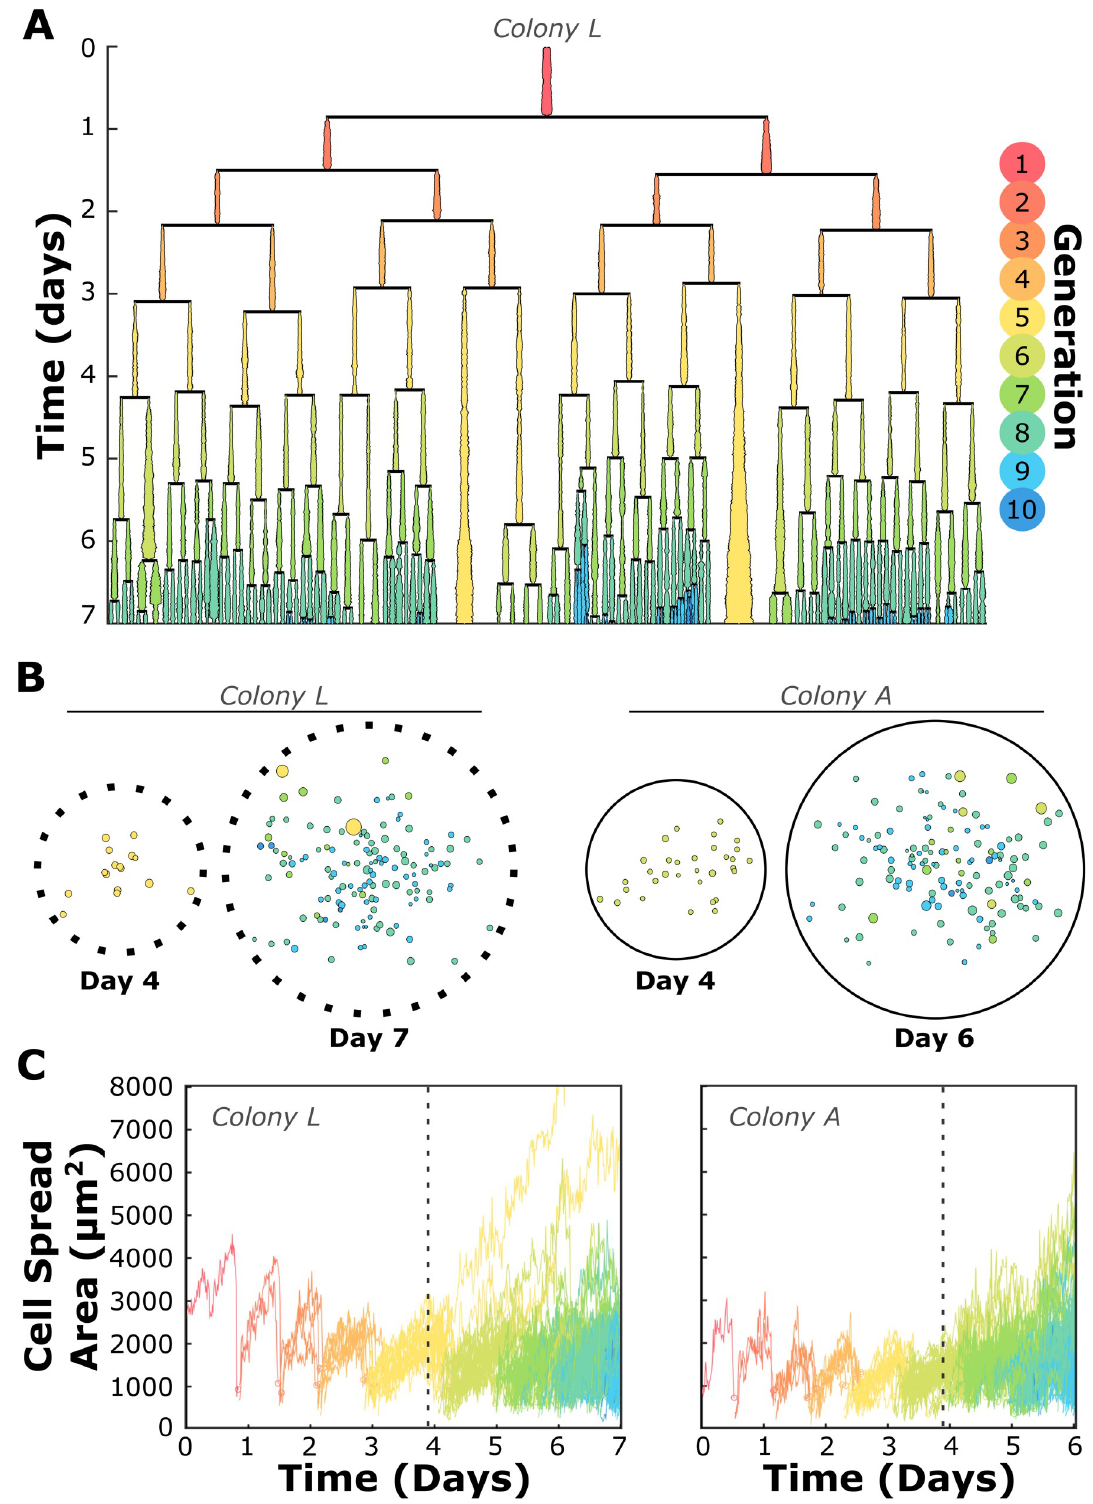
Fig 7. Heterogeneity arose in the most uniform single-cell-derived (SCD) colonies within seven days of development. (A) The lineage tree of one SCD colony studied long-term at the single-cell level demonstrates that even a uniformly-proliferating colony will produce large, senescent cells and asynchronous divisions within its progeny before becoming fully developed. Lineage line widths